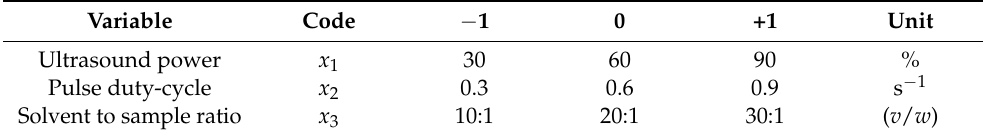
Table 1. Extraction variables and their